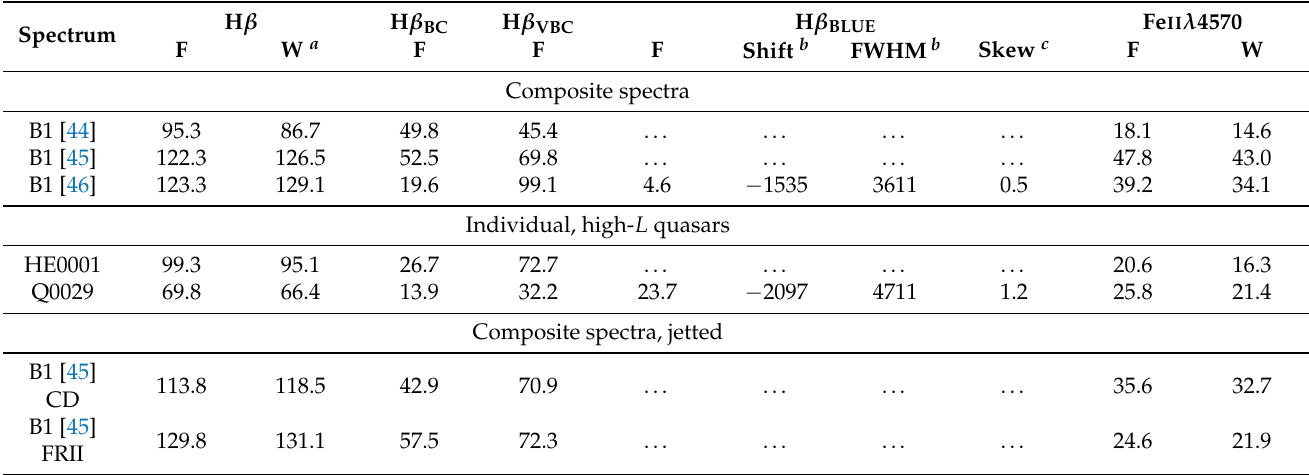
Table 2. Broadline properties measurements.